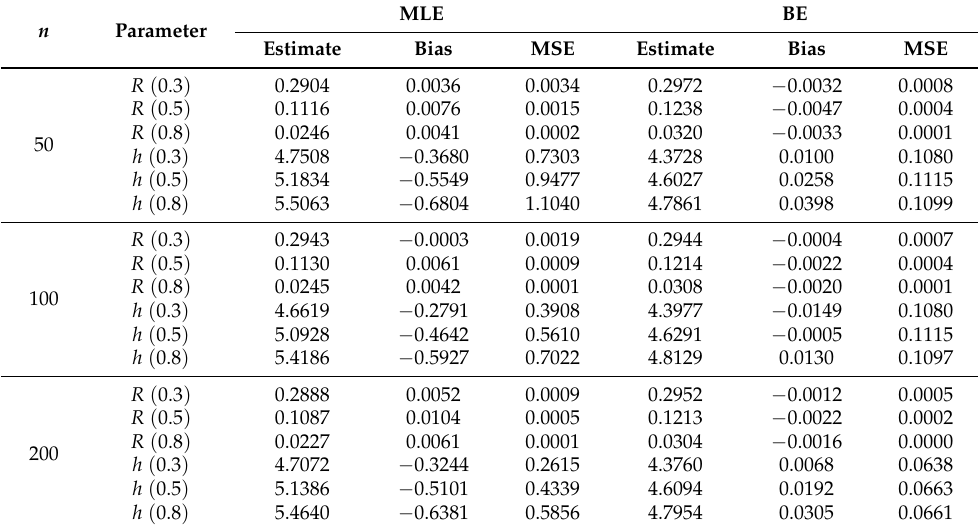
Table 7. Point estimates of R ( x ) and h ( x ) at x = { 0.3,0.5,0.8 } under Scheme 1.